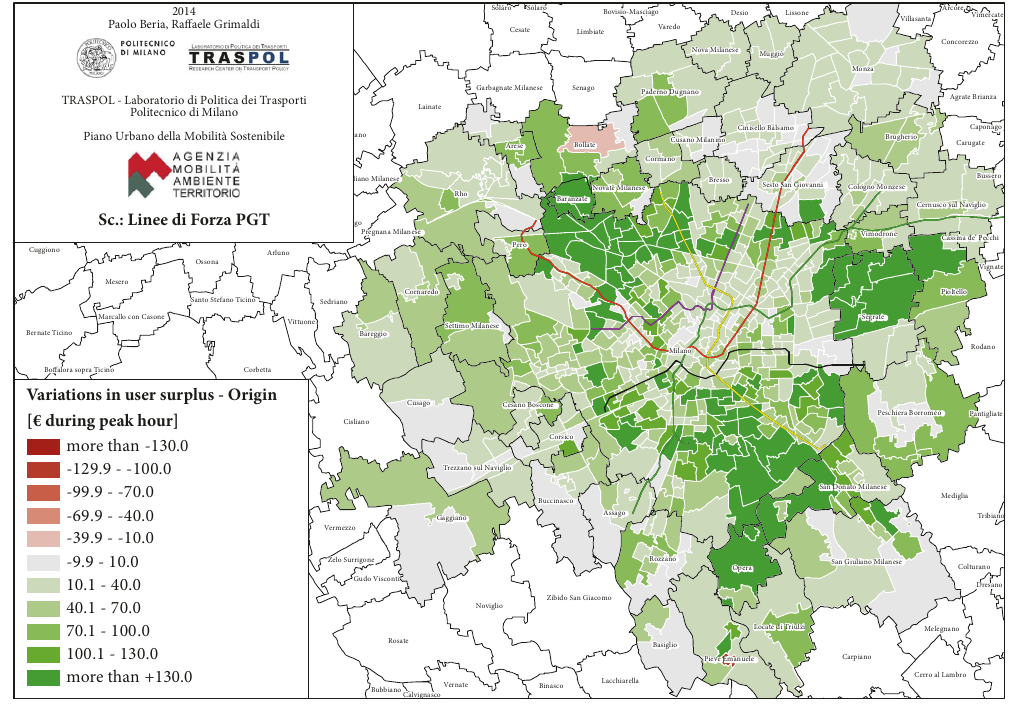
Figure 6: Variation in consumer surplus due to the 6 new high-performance public transport lines envisaged by the PGT (€ in the morning peak hour; our